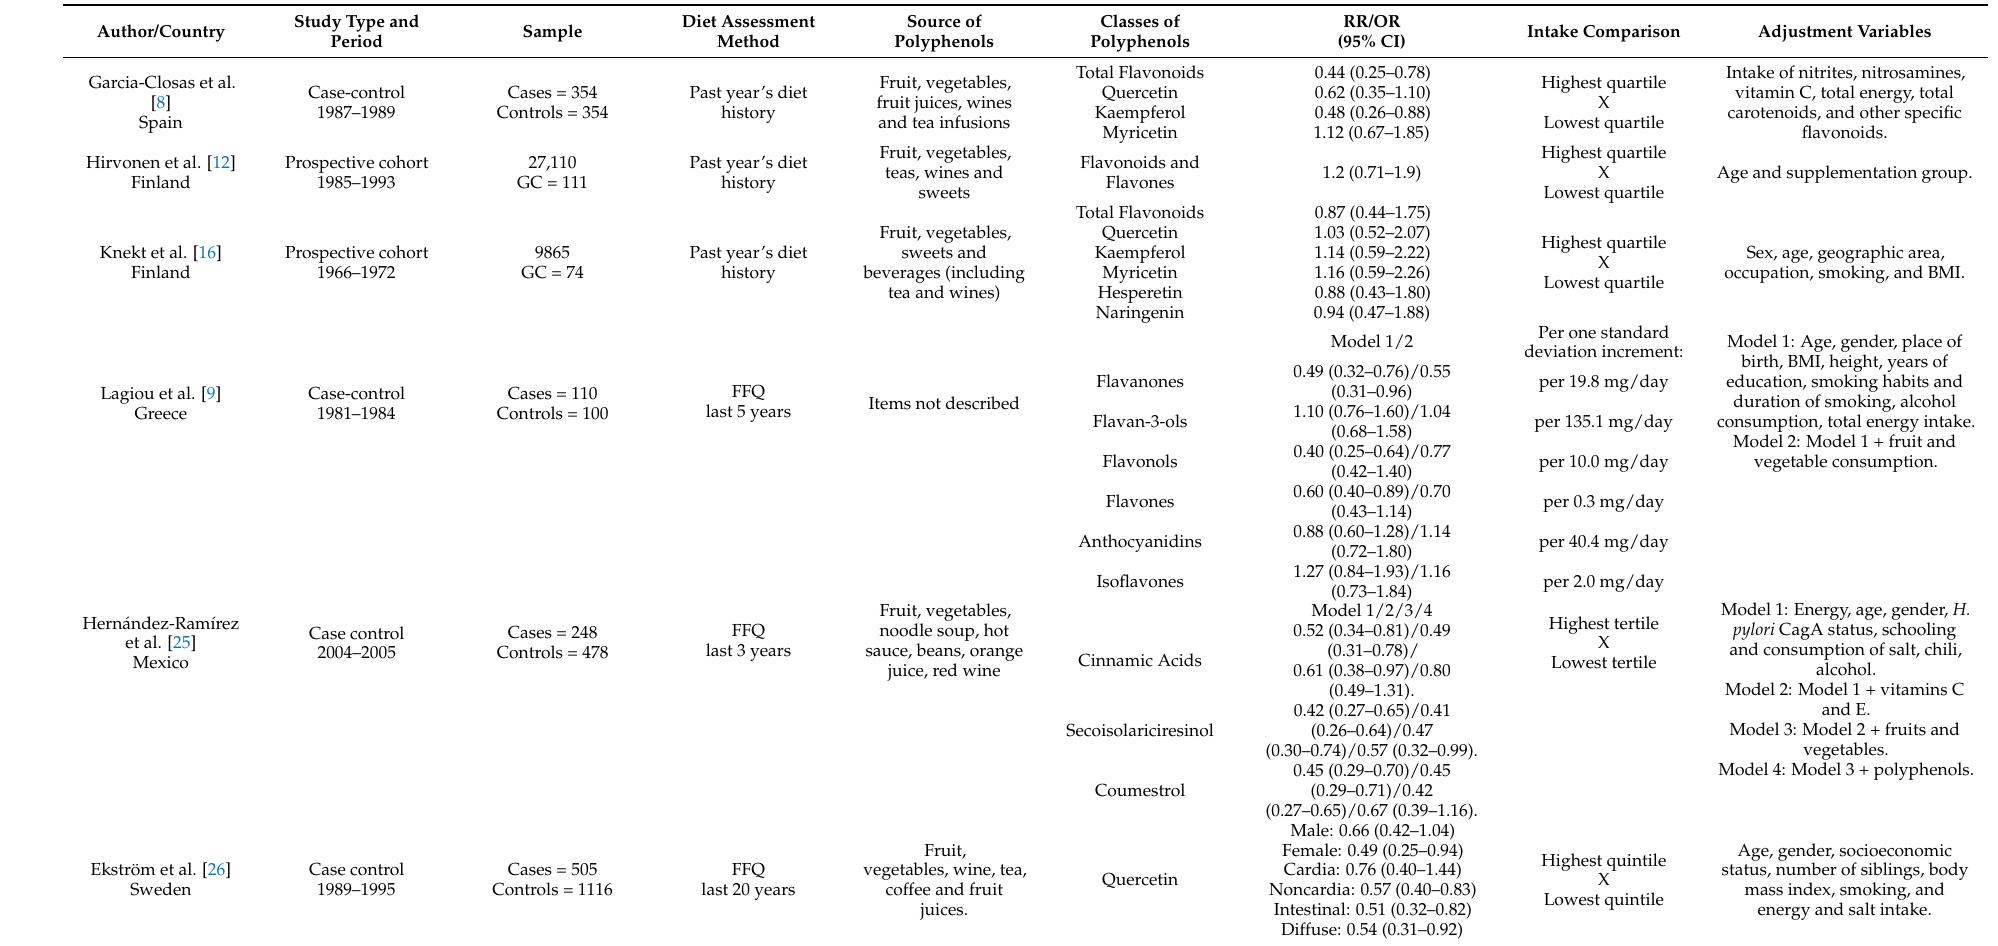
Table 1. Characteristics of studies on dietary polyphenol intake and gastric cancer